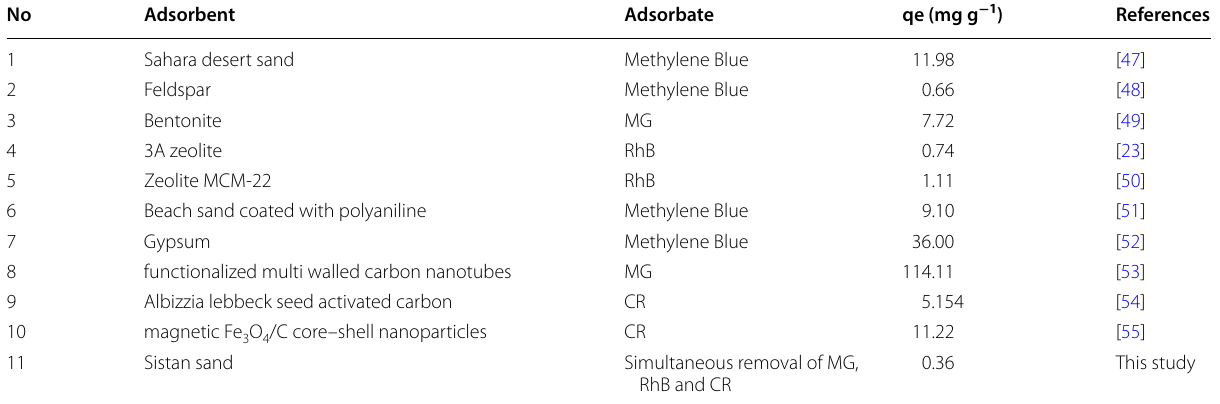
Table 6 A comparison on removal of MG, RhB and CR by different adsorbents